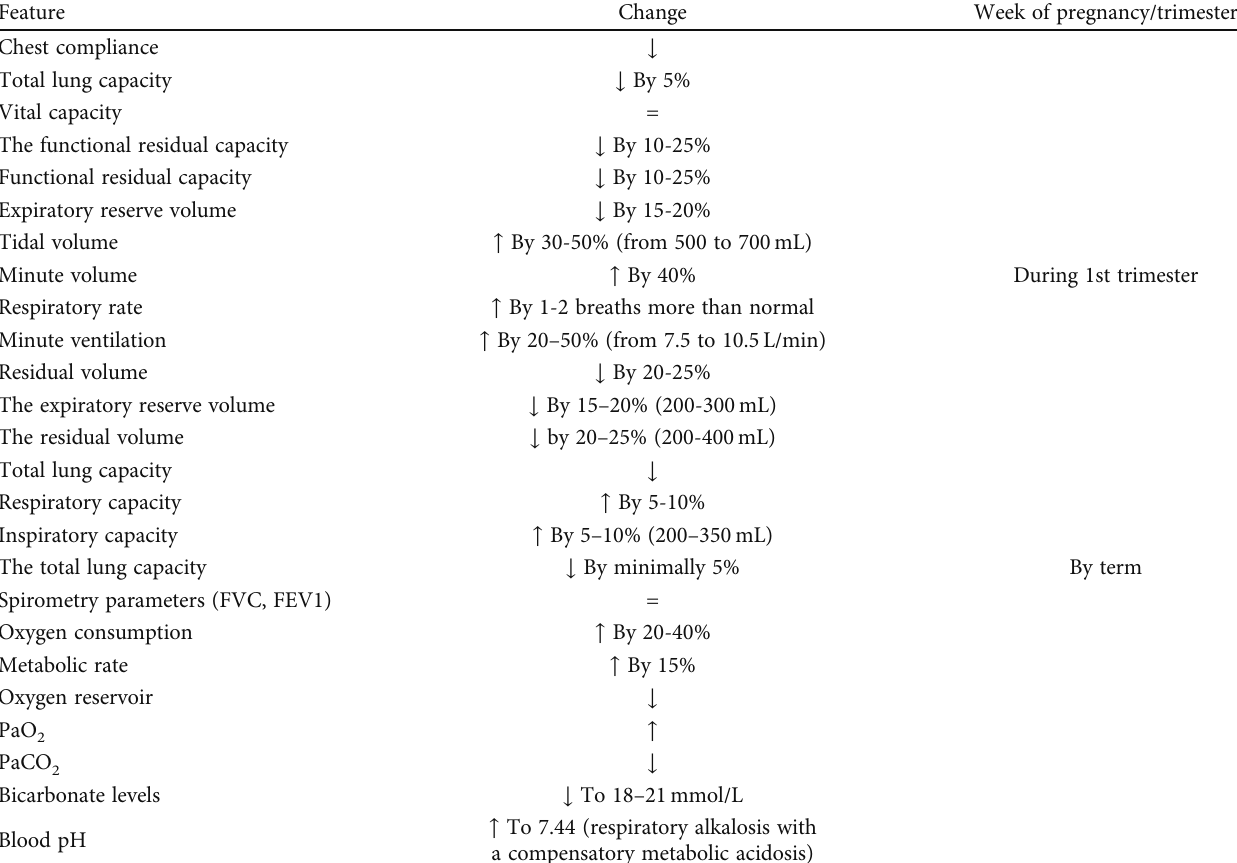
Table 3: Physiological changes of respiratory system during the pregnancy [37, 39 –